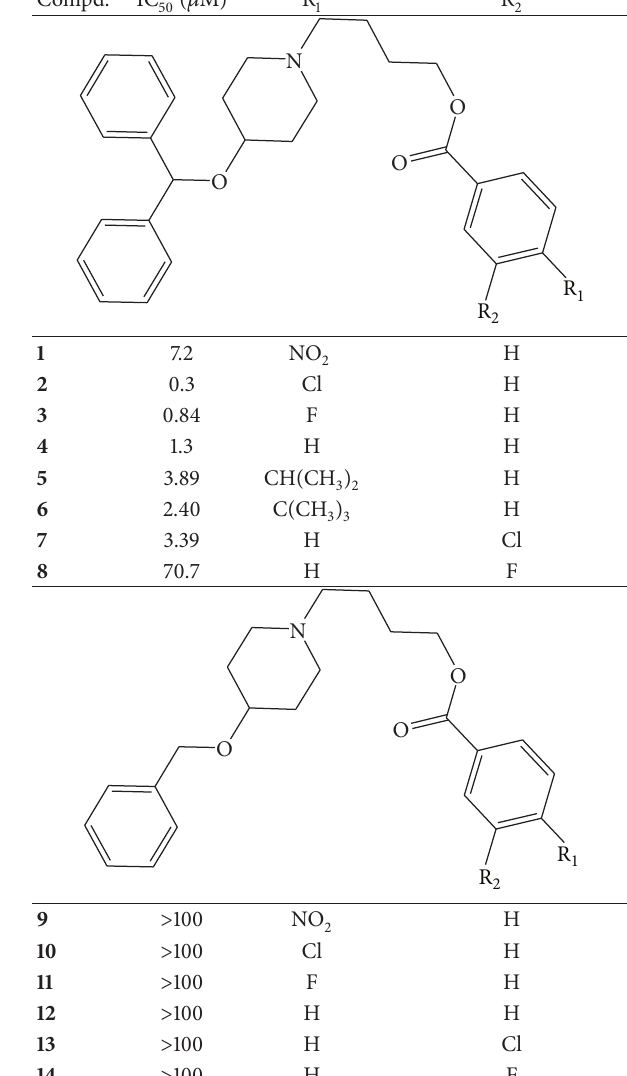
Table 1: Piperidine derivatives.